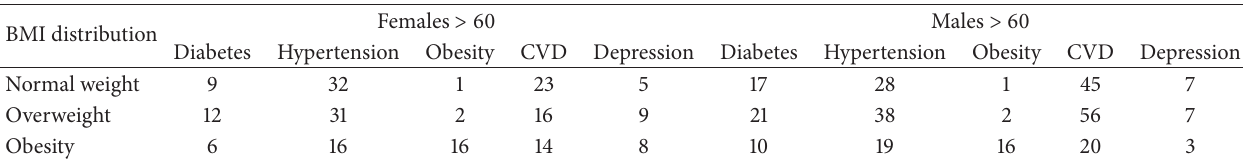
Table 3: The table depicts the number of > 60 male and female subjects distributed according to self-reported diagnosed diseases. BMI